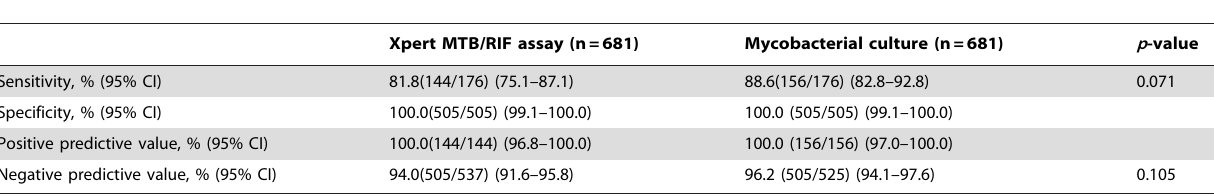
Table 3. Diagnostic accuracy of the Xpert MTB/RIF assay and mycobacterial culture using sputum specimens for the diagnosis of pulmonary